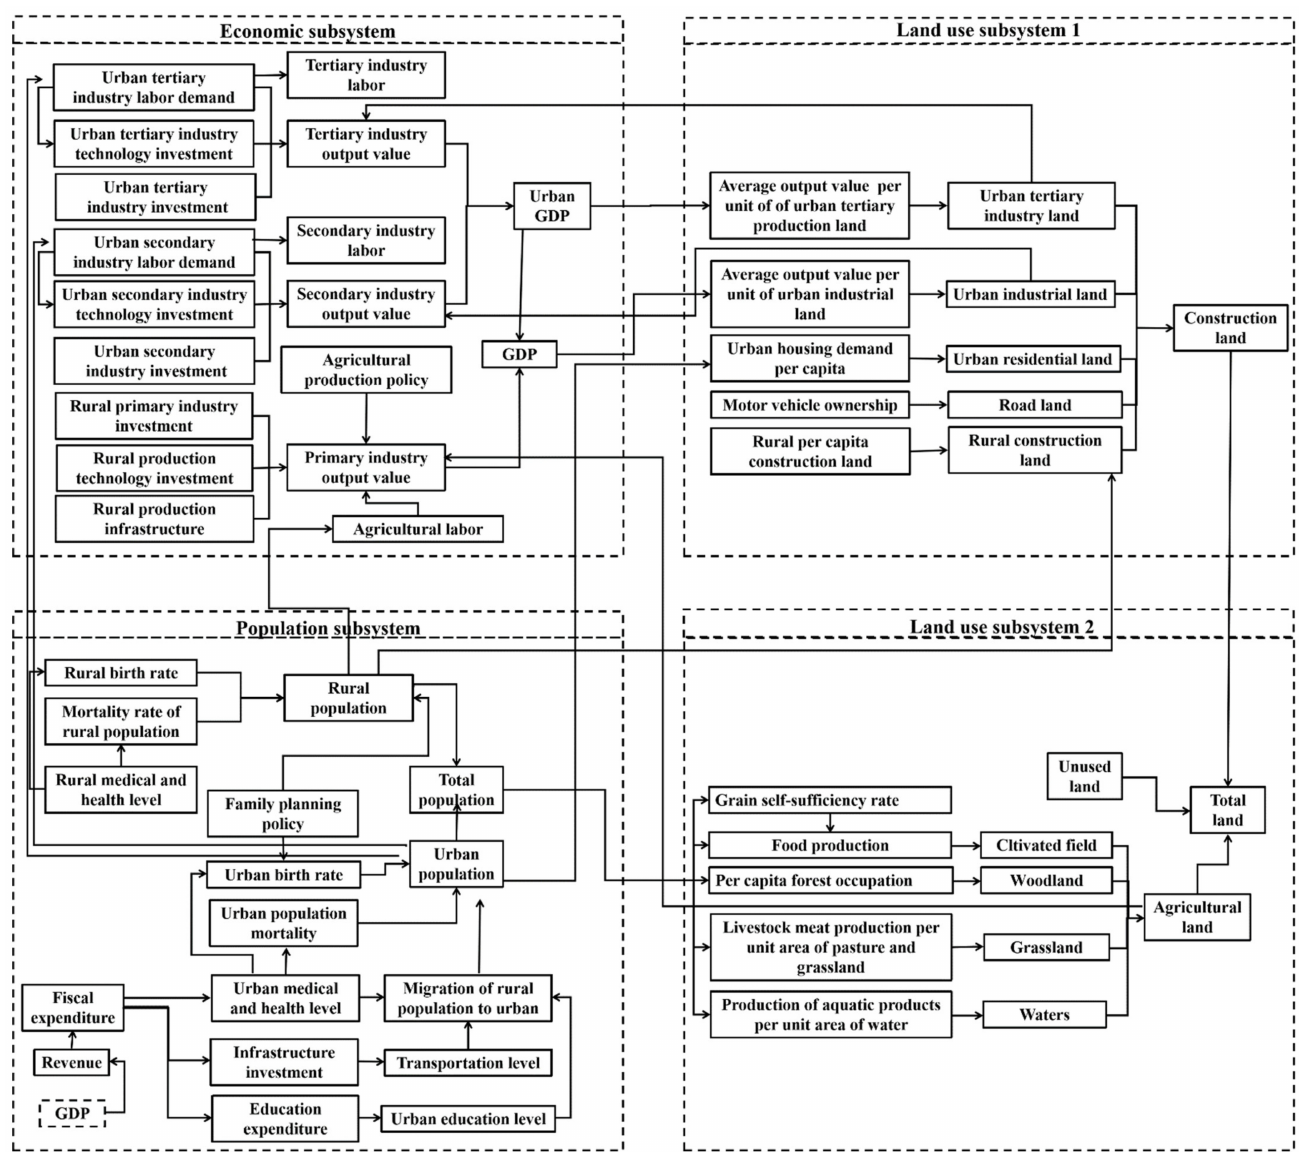
Figure 3. The structure of the SD